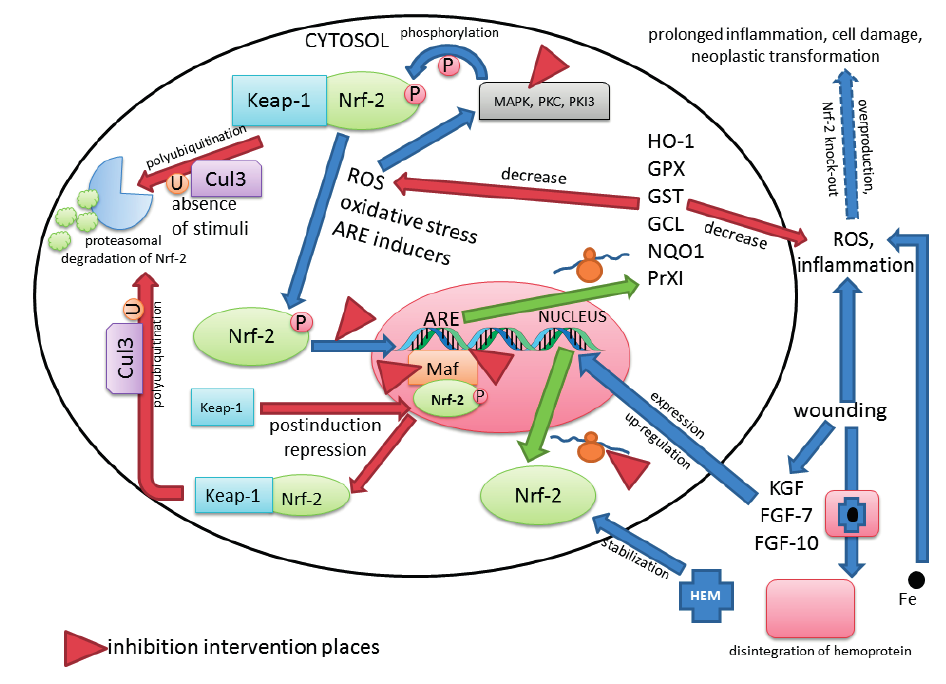
Fig. 2. Nrf2 pathway in wound